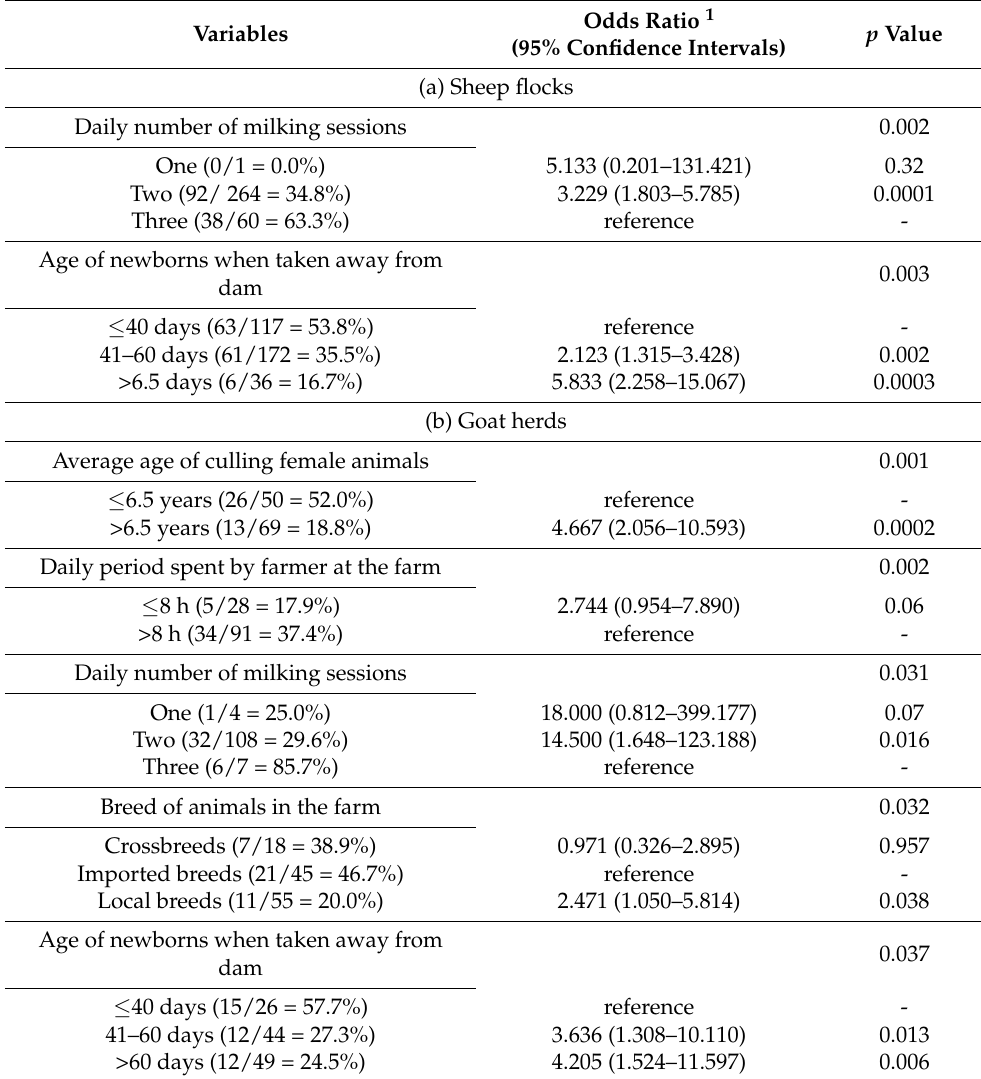
Table A1. Multivariable analysis for variables associated with optional vaccination against chlamydial abortion in 444 small ruminant farms in